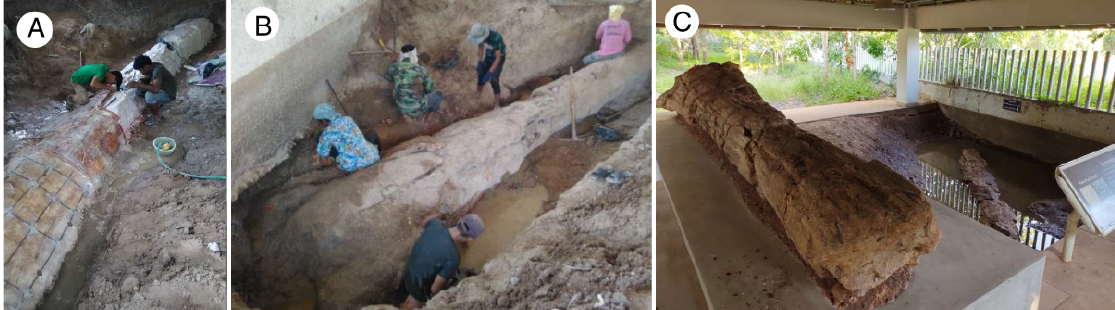
Figure 28. Conservation efforts at Khorat in 2016. ( A ) Workers prepare a mold for a log in wet ground so that a replica can be made. ( B ) Removal of the log so that it can be displayed on a pedestal. ( C ) Completed exhibit, with fossil log on a concrete pedestal and replica in excavation pit.